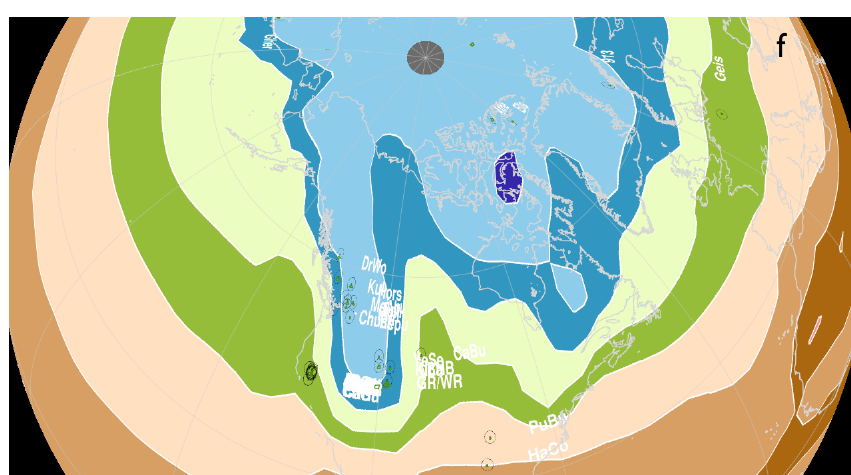
Fig. 1f. Figure 1 continued, see Fig. 1a for